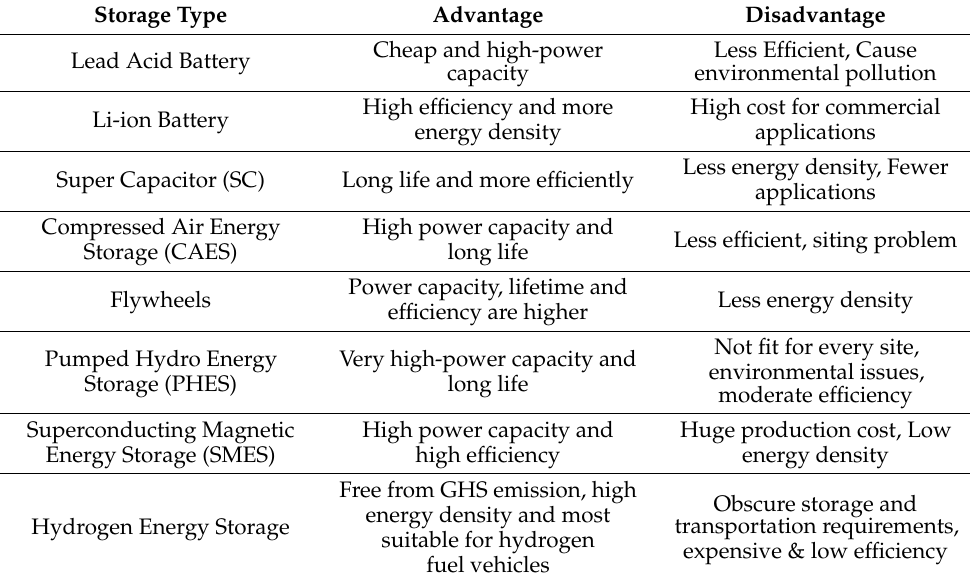
Table 3. High power and high energy storage.